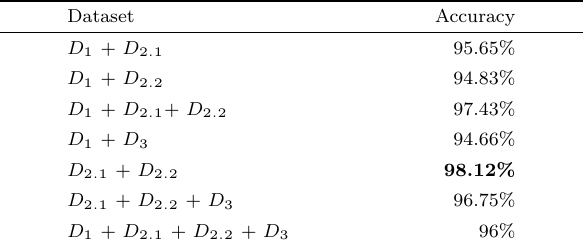
Table 6 Accuracy of the proposed fall detection system for combined